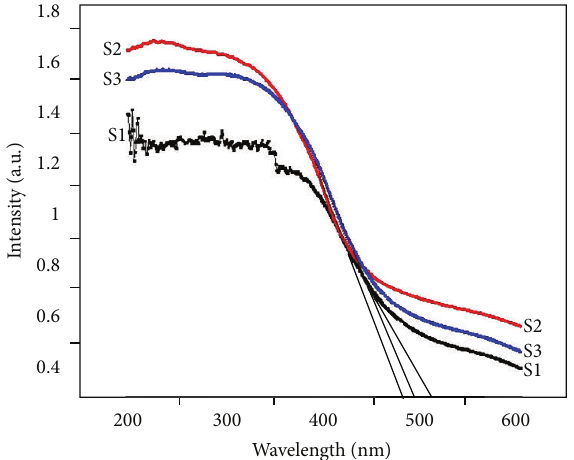
Figure 4: UV-Visible absorption spectra of MnWO 4